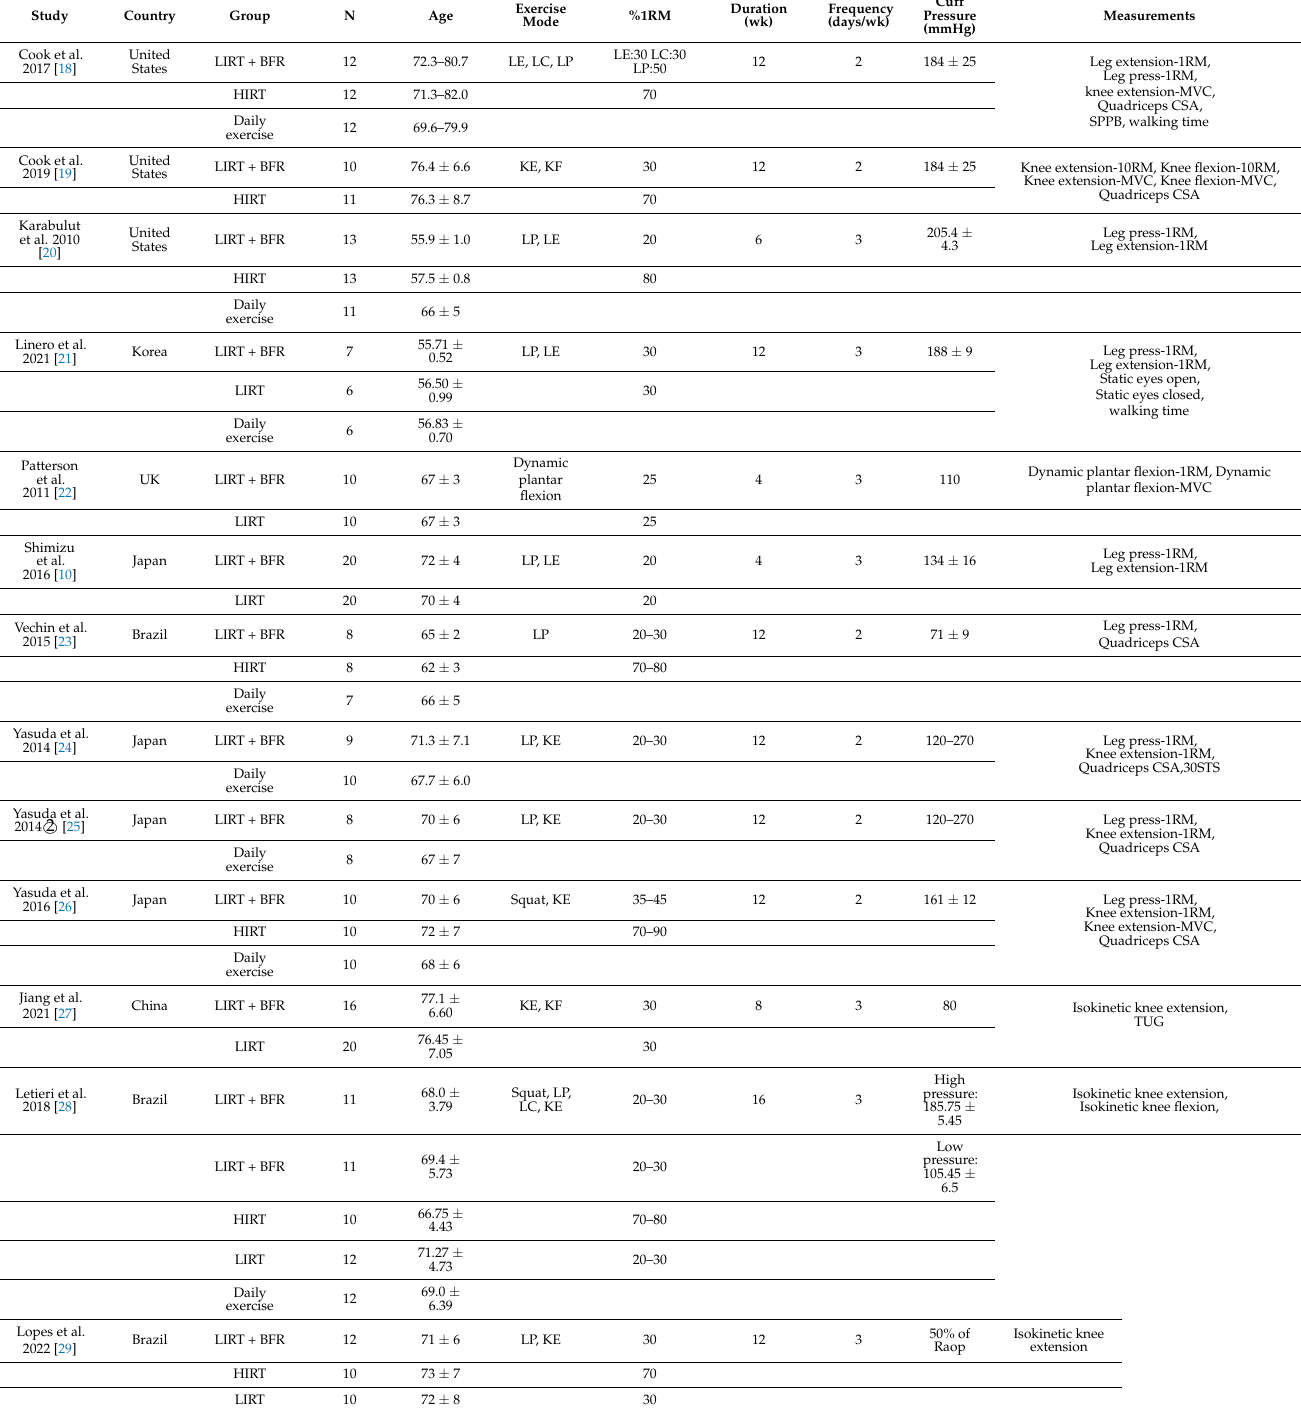
Table 1. Basic information of the literature included in the